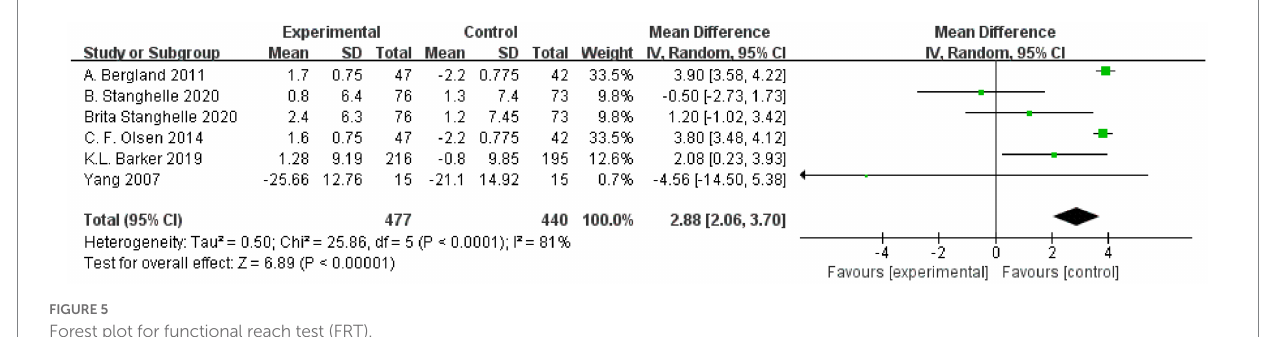
FIGURE 5 Forest plot for functional reach test